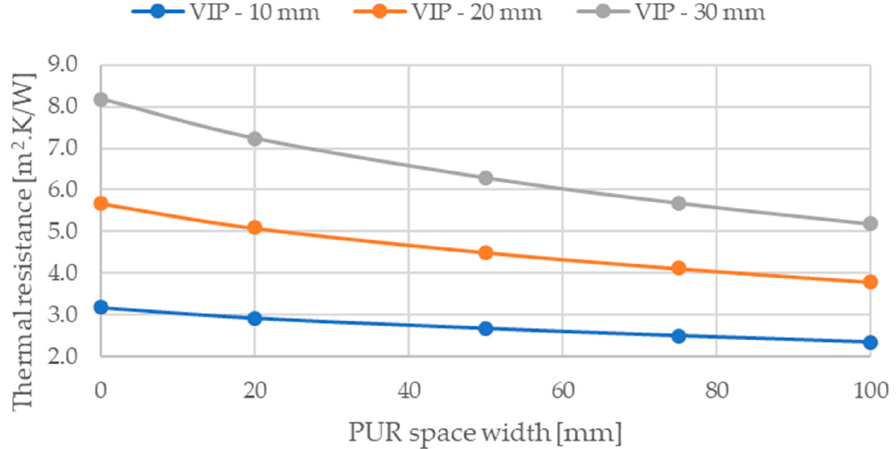
Figure 7. Dependence of thermal resistance of panels on PUR space width.